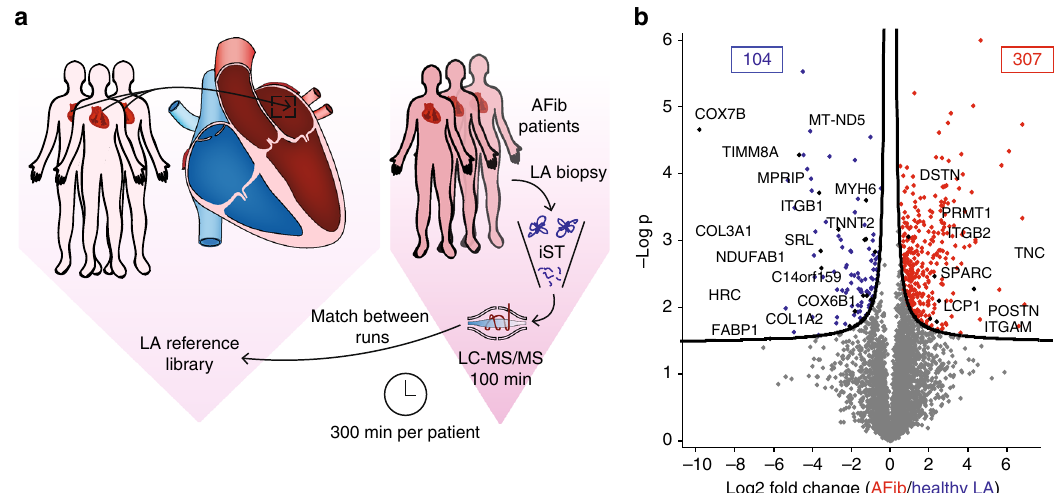
Fig. 6 Clinical application of the healthy human heart atlas to atrial fi brillation. a Experimental work fl ow: LA tissues from three atrial fi brillation patients (AFib) were single-runs of technical triplicates. Data were matched against the healthy human LA library. b Volcano plot of the p values vs. the log2 protein abundance differences in AFib compared to healthy LA. Signi fi cantly up- and downregulated proteins are highlighted in red and blue, respectively (FDR